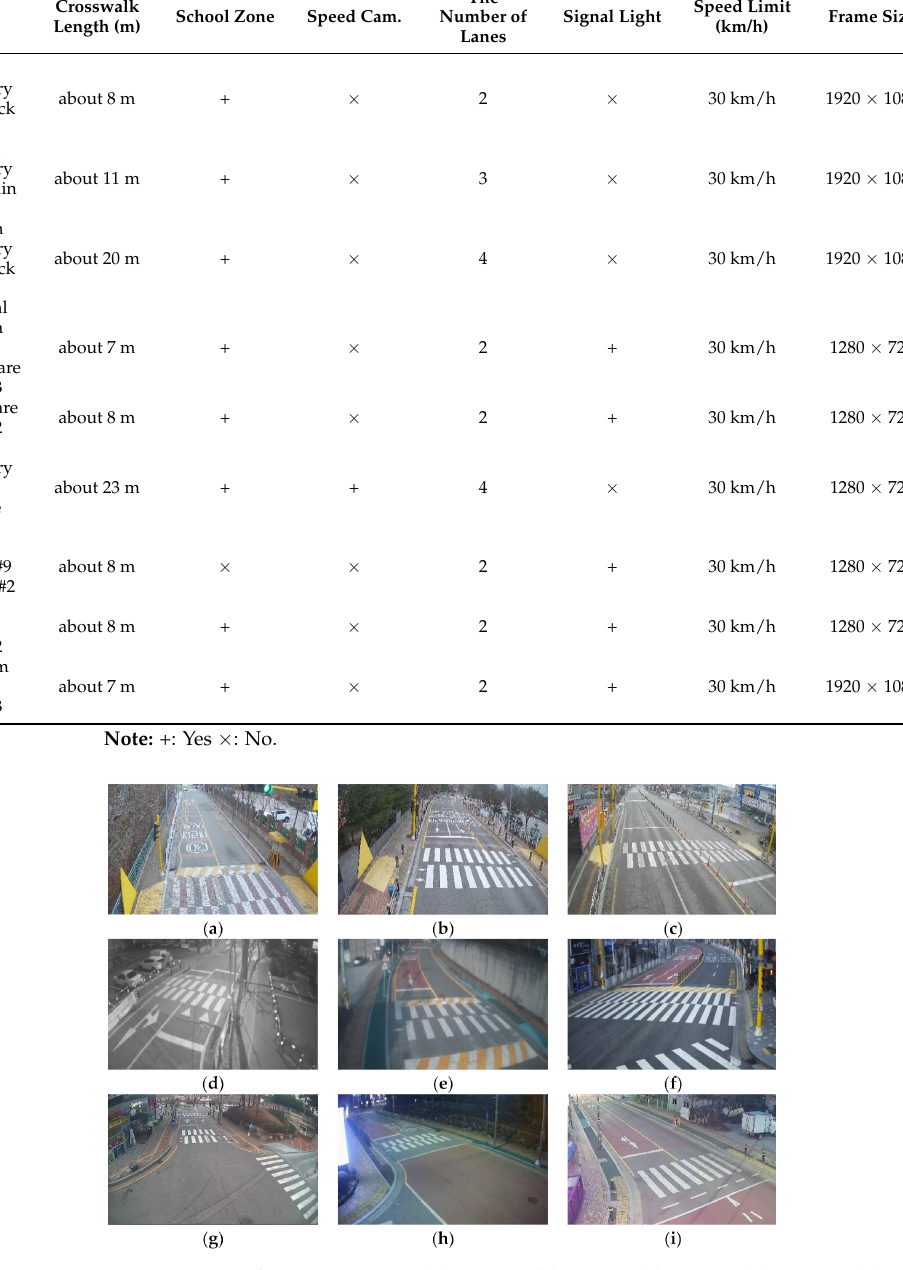
Figure 1. Actual CCTV views in ( a ) Spot A; ( b ) Spot B; ( c ) Spot C; ( d ) Spot D; ( e ) Spot E; ( f ) Spot F; ( g ) Spot G; ( h ) Spot H; and ( i ) Spot